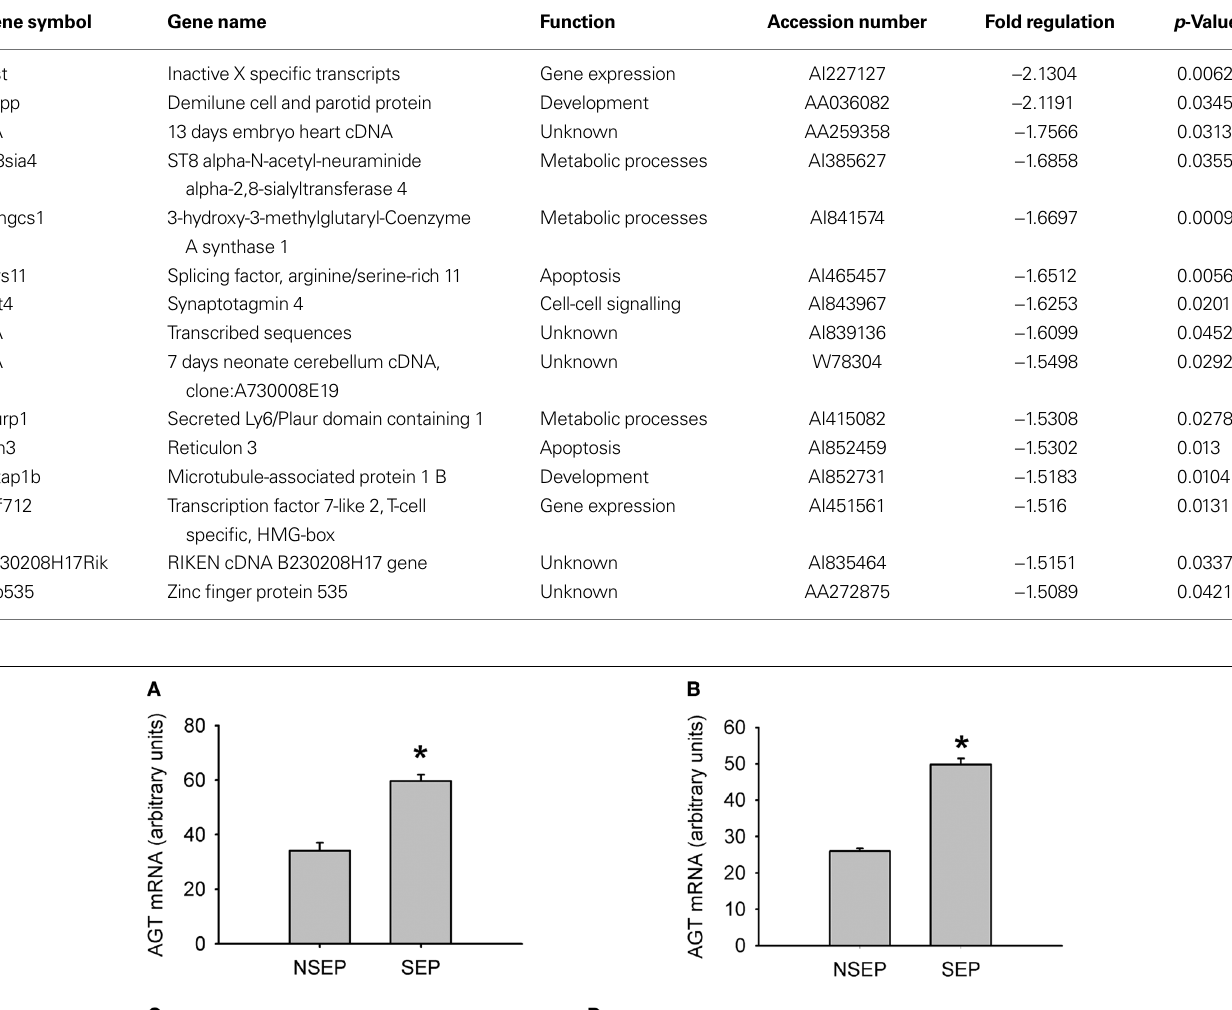
Table 2 | List of signifi cantly down-regulated genes in the PVN region of the hypothalamus in 9-day-old maternally separated mouse pups compared to controls.